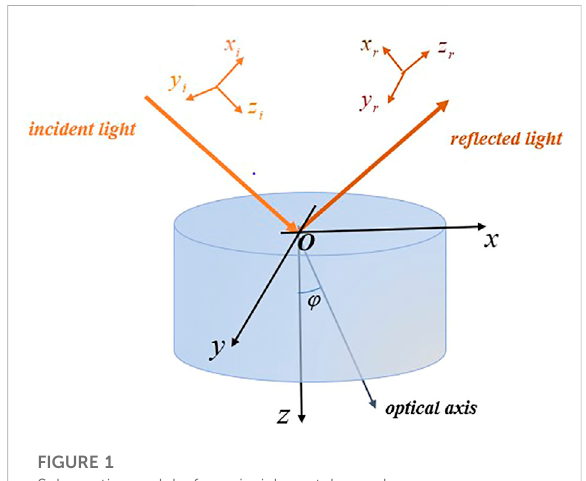
FIGURE 1 Schematic model of a uniaxial crystal